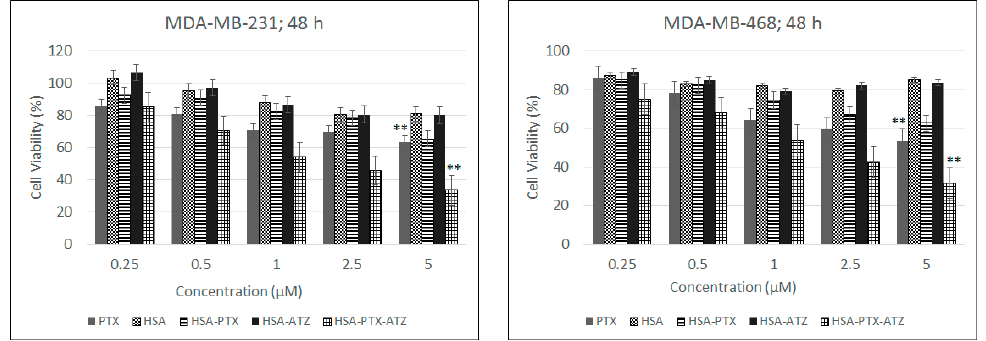
Figure 4. In vitro cytotoxicity studies in MDA-MB-231 and MDA-MB-468 cell lines respectively for the hypoxia targeting drug delivery system HSA-PTX-ATZ. ** Statistically significant. 2.7. Comparative In Vitro Cytotoxicity Studies for Normoxic and Hypoxic Conditions